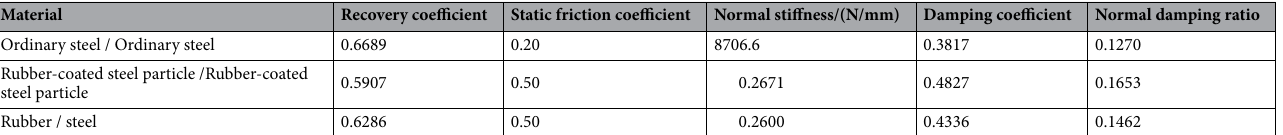
Table 2. Interaction parameters between two kinds of materials.